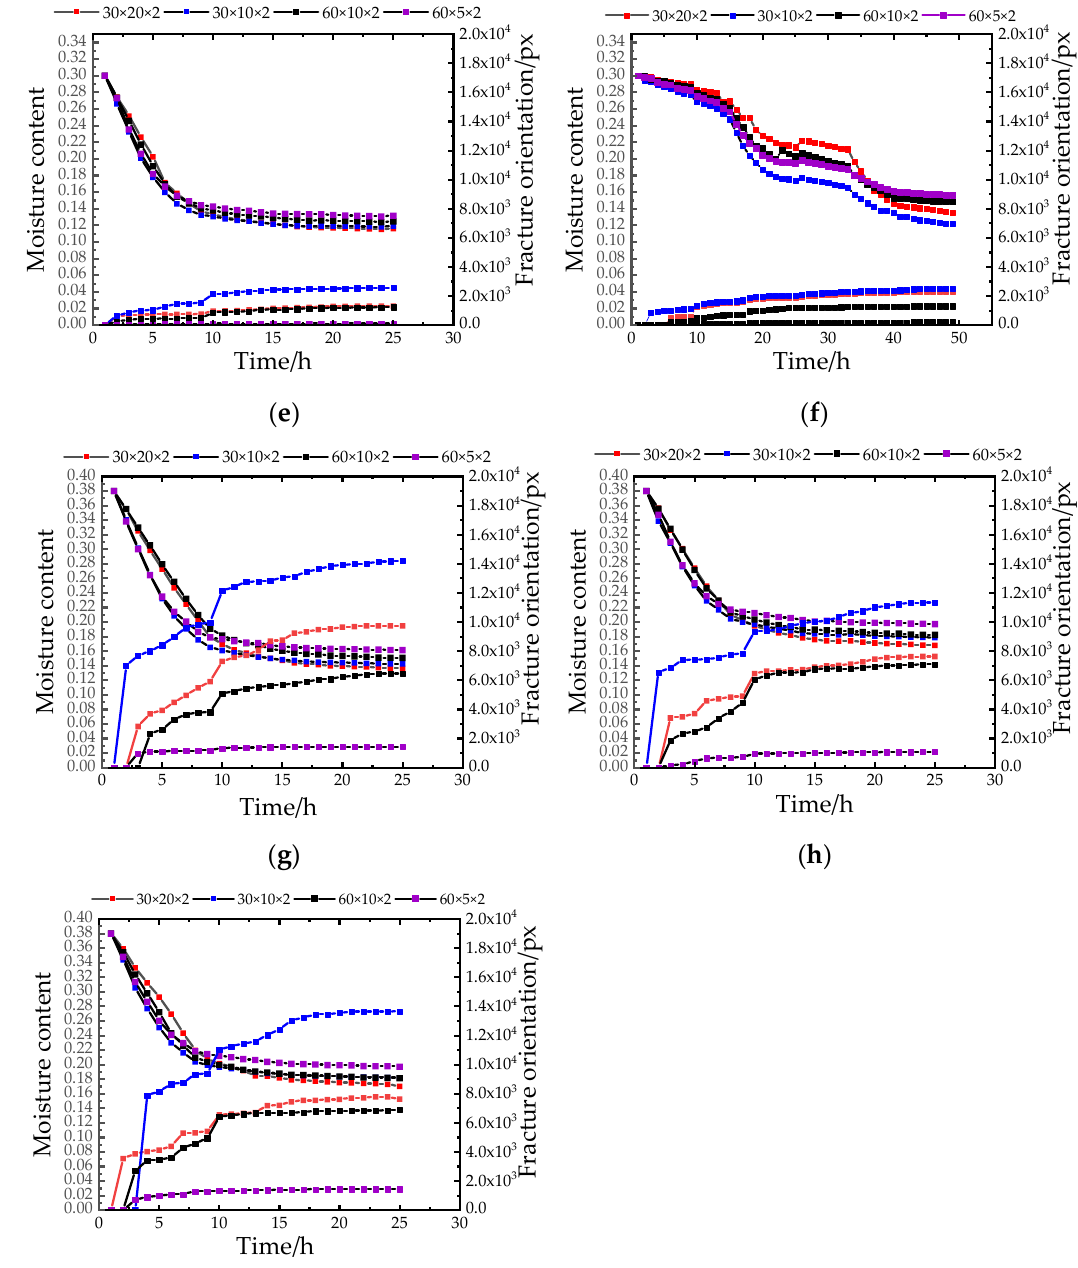
Figure 8. Crack orientation curve. ( a ) the change curve of crack orientation under 21% initial moisture content and 30% humidity; ( b ) the change curve of crack orientation under 21% initial moisture content and 67% humidity; ( c ) the change curve of crack orientation under 21% initial moisture content and 95% humidity; ( d ) the crack orientation change curve under 30% initial moisture content and 30% humidity; ( e ) the crack orientation change under 30% initial moisture content and 67% humidity; ( f ) the change curve of crack orientation under 30% initial moisture content and 95% humidity; ( g ) the crack change curve 38% initial moisture content and 30% humidity; ( h ) the change curve of crack orientation under 38% initial moisture content and 67% humidity; ( i ) the change curve of crack orientation under 38% initial moisture content and 95% humidity.